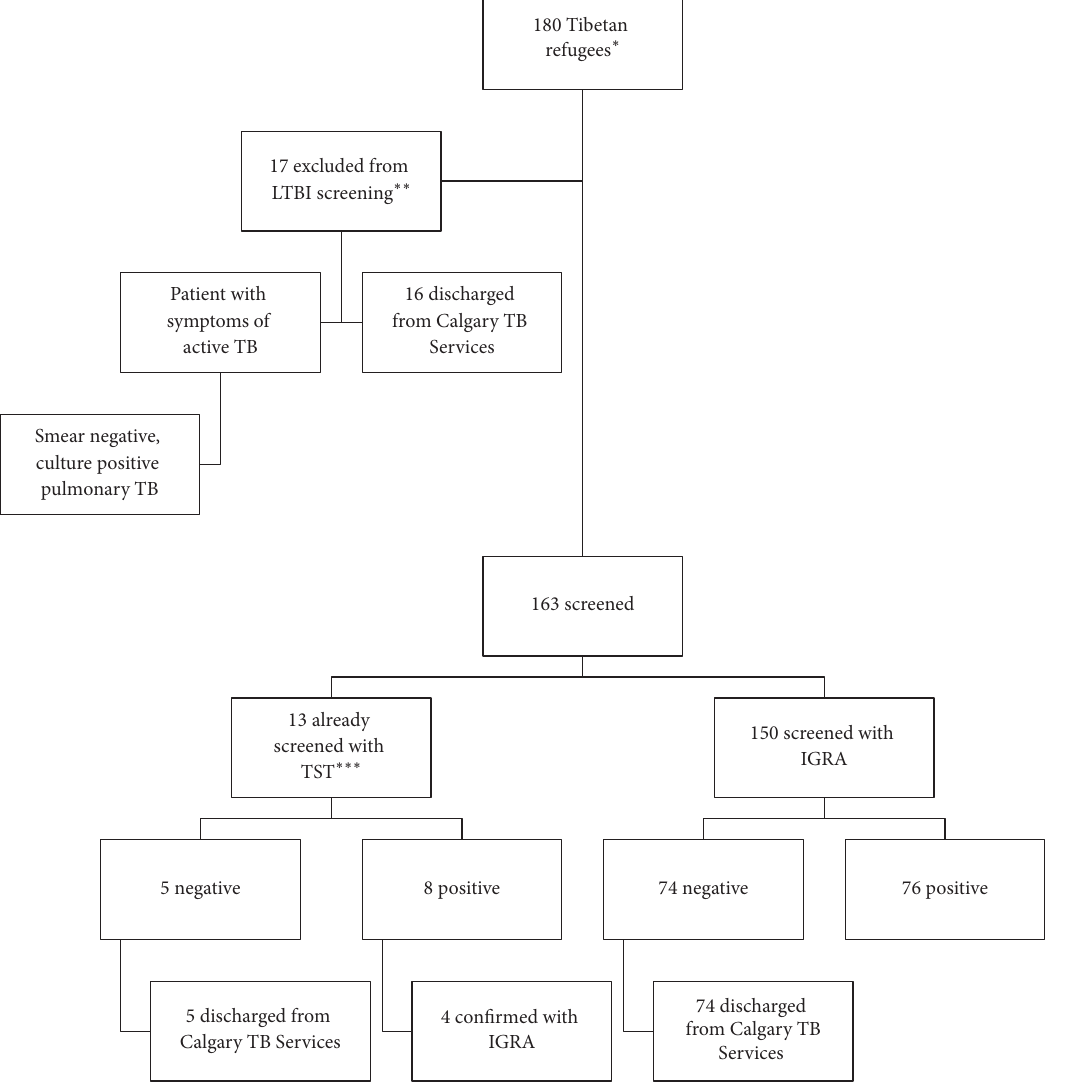
Figure 1: Screening for Tibetan refugees between 2014 and 2016. ∗ 100 percent of Tibetan refugees are assessed for active TB within 30 days of arrival in Canada at Calgary TB Services. ∗∗ One patient was excluded for age over 50 years with no additional risk factors for reactivation TB, two patients had history of extrapulmonary TB, thirteen patients had history of treated pulmonary TB, and one patient had history of NTM infection treated with sufficient duration of rifampin to constitute treatment for LTBI. ∗∗∗ Some patients had been assessed by Calgary Refugee Clinic or a primary care center where they had received LTBI screening with